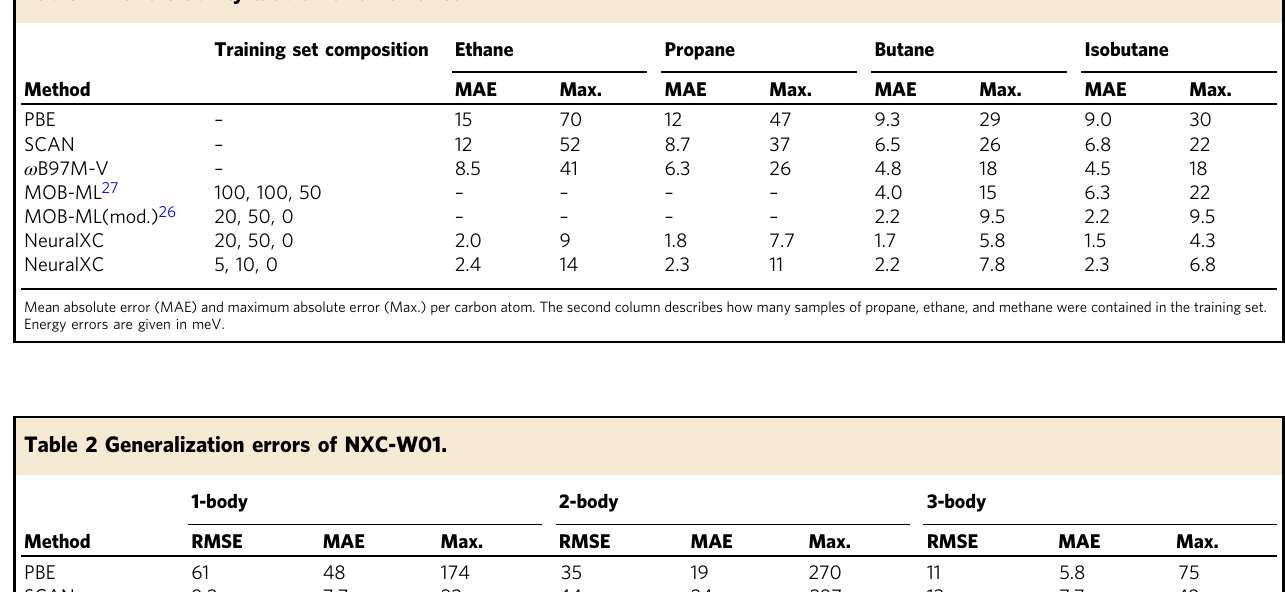
Table 1 Transferability task on small alkanes.